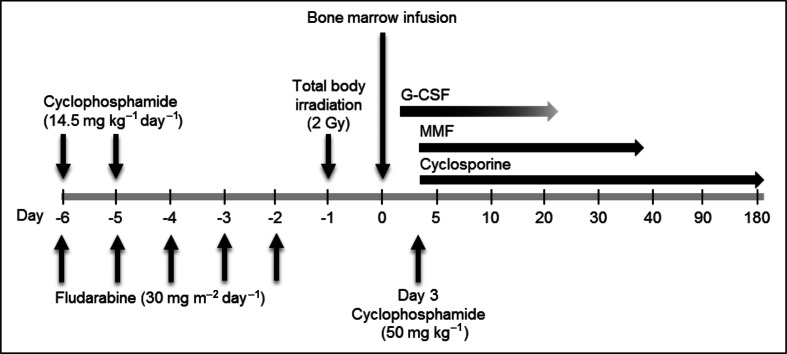
Non-myeloablative conditioning and prophylaxis for GVHD. The patient received non-myeloablative conditioning including cyclophosphamide and fludarabine starting on day −6 and total body irradiation on day −1. Therapy for GVHD included granulocyte-colony stimulating factor (G-CSF), mycophenolate mofetil (MMF) and cyclosporine.